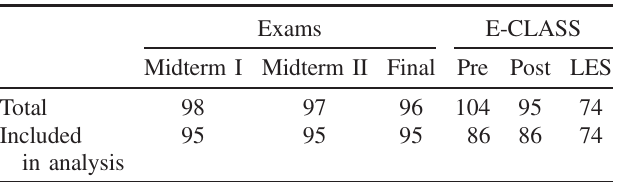
TABLE VIII. Total number of students in each dataset in semester 1 before filtering for valid responses compared to the responses included in the analyses. Includes only students who consented to participate in the